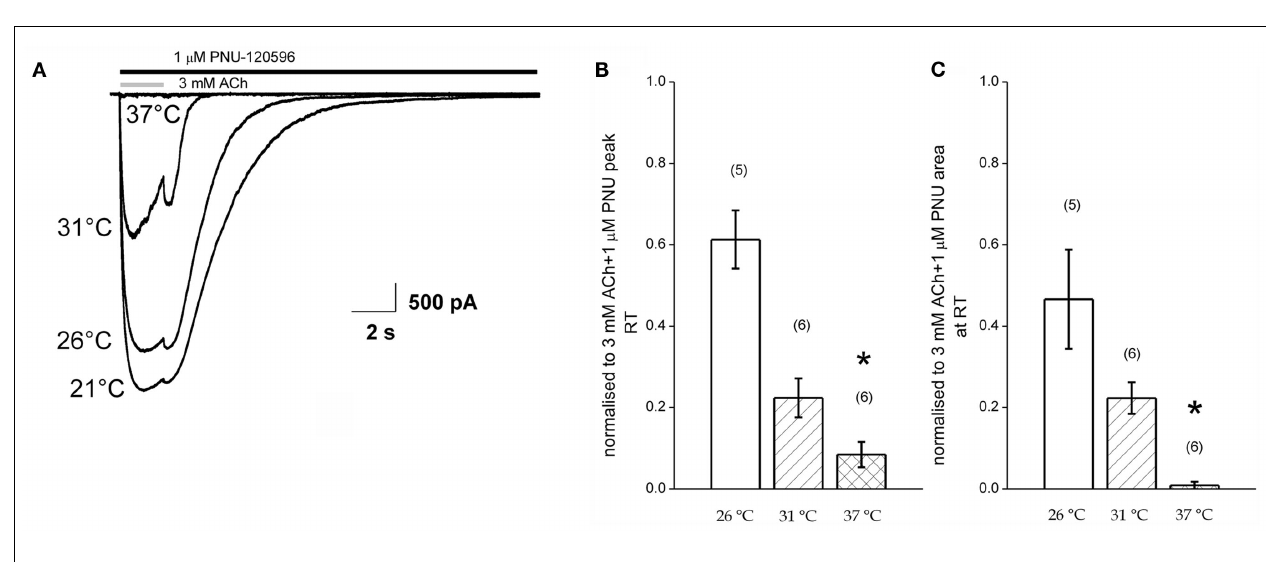
amplitude (left) and charge transfer (right) of response to ACh in the presence of PNU in three different recording temperature bins. Data are normalized to the corresponding responses recorded at room